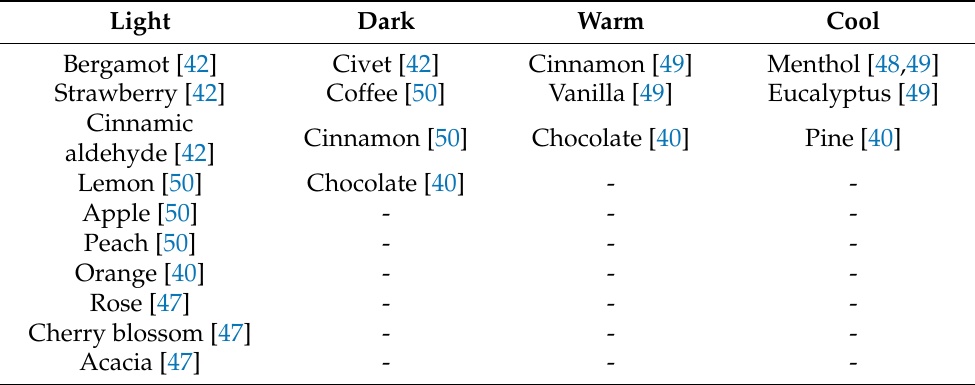
Table 4. Correspondence between scent and color dimensions described in previous